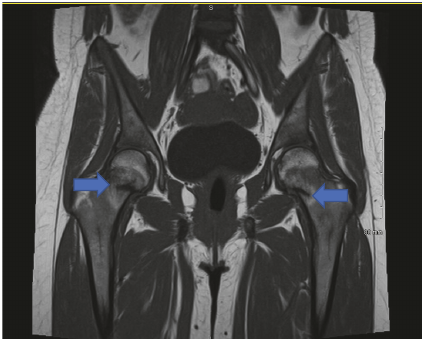
Figure 1: MRI Pelvis showing bilateral stress insufficiency fractures of the hip, femoral neck . On the right, the transcervical low signal line extends to the superior lateral cortex and is associated with marrow edema, suggestive of a nondisplaced transcervical fracture.